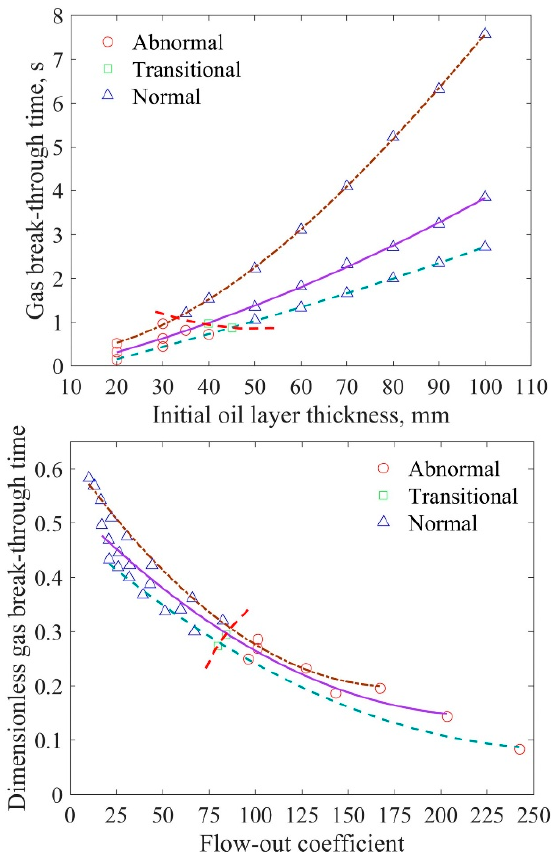
Figure 13. E ff ect of pressure di ff erence on the drainage end state. Initial l–l interface level: 10 mm, Figure 13. Effect of pressure difference on the drainage end state. Initial l–l interface level: 10 mm, oil oil viscosity: 0.131 Pa · s, pressure di ff erences: 0.2 bar (dash-dotted line), 0.3 bar (solid line), 0.4 bar viscosity: 0.131 Pa·s, pressure differences: 0.2 bar (dash-dotted line), 0.3 bar (solid line), 0.4 bar (dashed (dashed line).